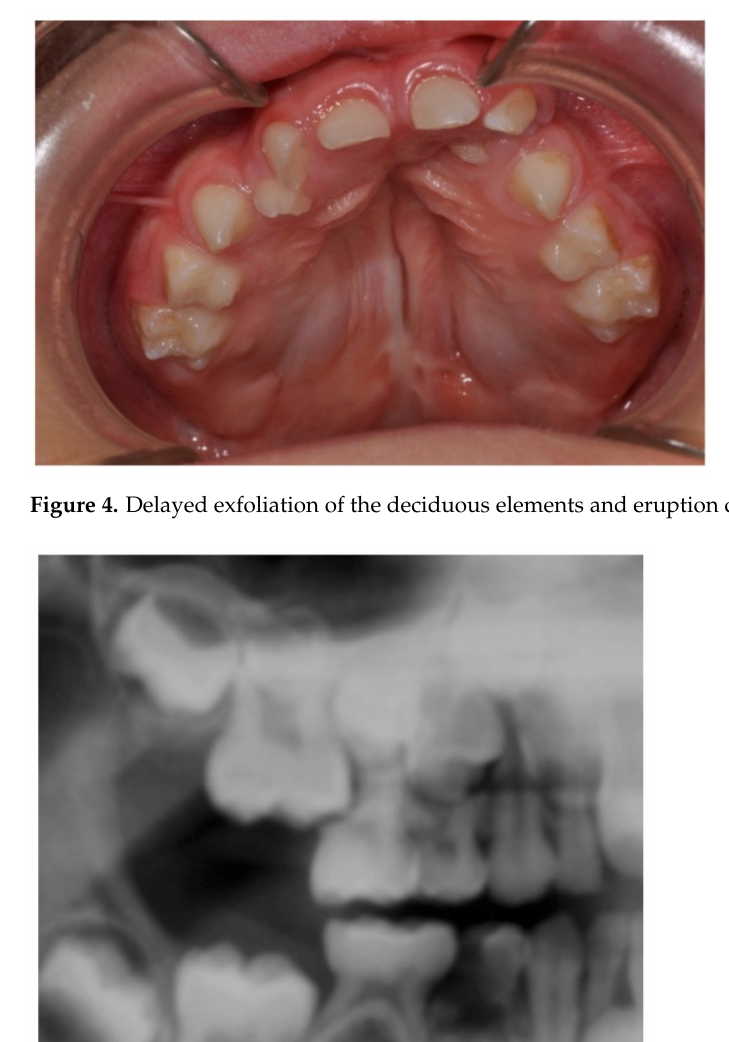
Figure 3. Example of patient with shape anomalies.